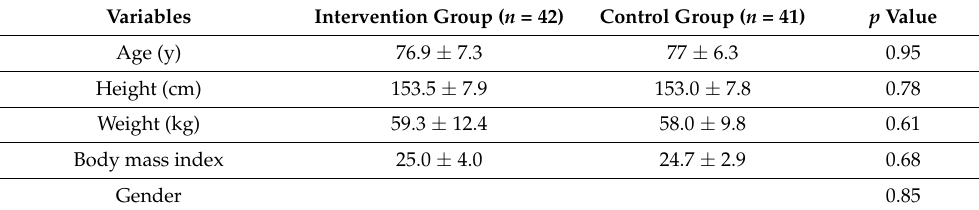
Figure 2. Demonstration of post − pre difference in five mobility performance of the intervention (black bar) and control (white bar) groups. ( A ) Diff − SPPB, the mean score of SPPB at post test − the mean score of SPPB at pretest. ( B ) Diff − OLS, the mean score of OLS at post test − the mean score of OLS at pretest. ( C ) Diff − FR, the mean score of FR at post test − the mean score of FR at pretest. ( D ) Diff − TUG, the mean score of TUG at pretest − the mean score of TUG at post test.; ( E ) Diff − 10 − m WT, the mean score of 10 − m WT at pretest − the mean score of 10 − m WT at post test. Statistics by two way repeated measures ANOVA. *: p < 0.05; ***: p < 0.001. Table 2. Comparison of the demographic data between intervention and control